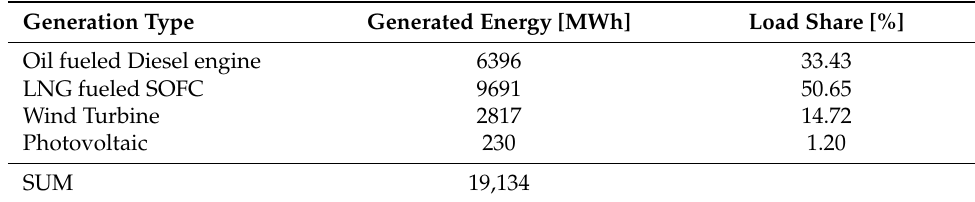
Table 10. Yearly aggregated results for the generated energy by type.